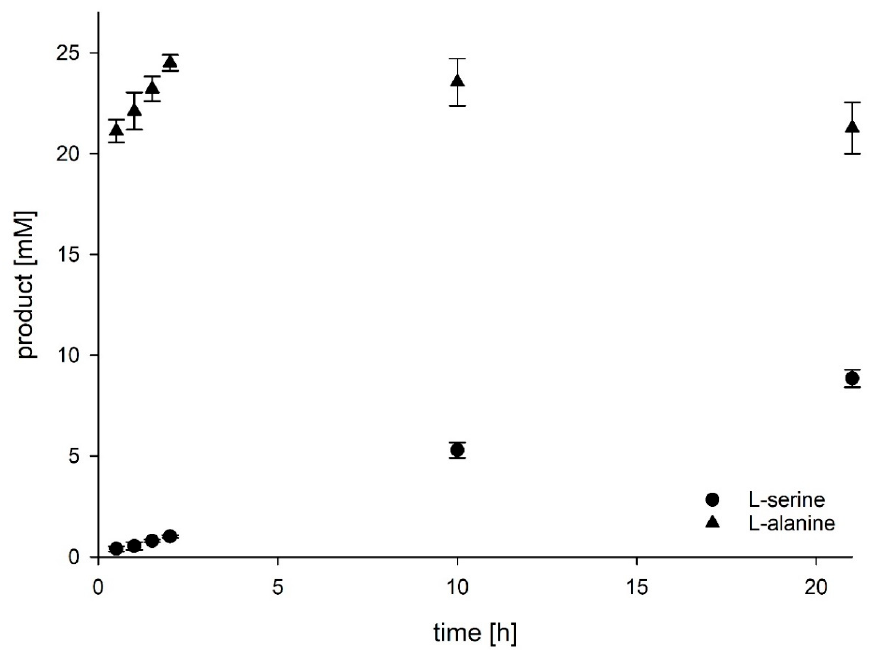
Figure 3. Time-dependent formation of L-alanine and L-serine by the improved cascade reaction. Reaction mixtures contained enzymes, 150 mM ammonium sulfate, 5 mM NAD + , 25 mM KDG and 100 mM KP i buffer pH 8.0 at 50 °C. 1 U of AfAlaDH, TlGR and MjAlDH and 0.5 U of PtKDGA were used, based on the activity of the respective enzymes in the buffer KP i pH 8.0. As an approximation, the TIGR was quantified using the reverse reaction.